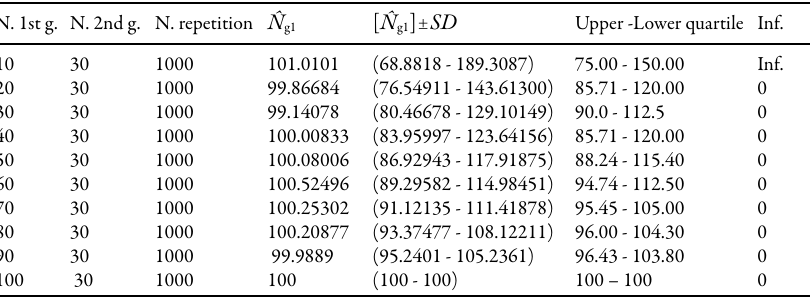
Table 3. The three statistics of experiment 3 of the virtual DNA data by simulation. The number of sampling from first generation is ‘N. 1st g.’. The number of sampling from second generation is ‘N. 2nd g.’. The number of repetitions of the simulation is ‘N. repetition’. The mean value of the estimated effective population size of the first generation (the first statistic) is  g1 . The standard deviation of  g1 (the second statistic) is [  g1 ]  SD. The upper quartile and lower quartile of the estimated effective population size of the first generation (the third statistic) is ‘Upper – Lower quartile’. If we could not measure  g1 after 1000 times, we denoted the situation as ‘Inf.’, which is the abbreviated form of Infinite (i.e. unmeasurable).